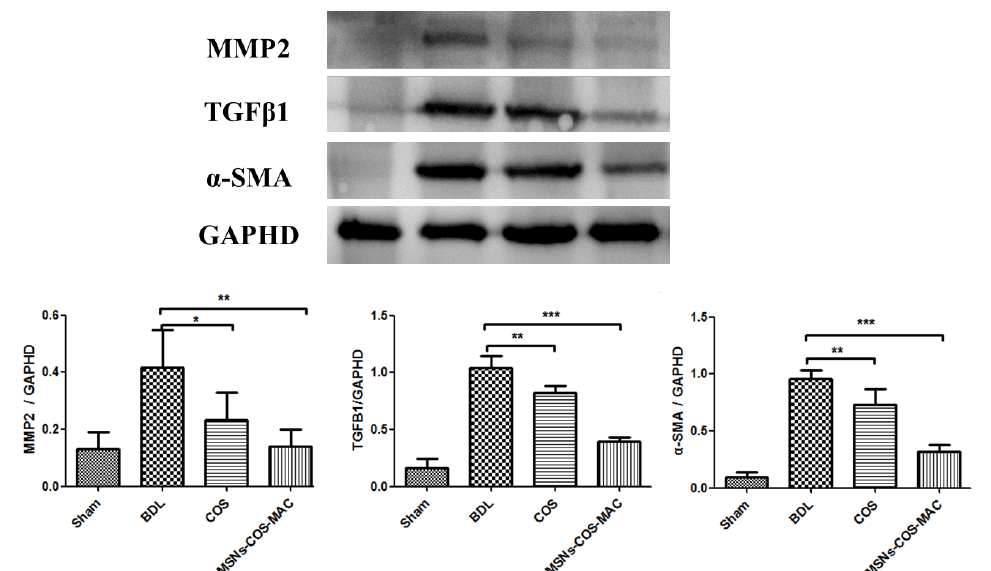
Figure 7. Western blot analysis and semi-quantitation of α -SMA, TGF- β and MMP2 protein levels in liver tissue. The values are expressed as the mean ± SD of four independent experiments. *** p < 0.001, ** p < 0.01 and * p < 0.05, significantly different from the BDL group.